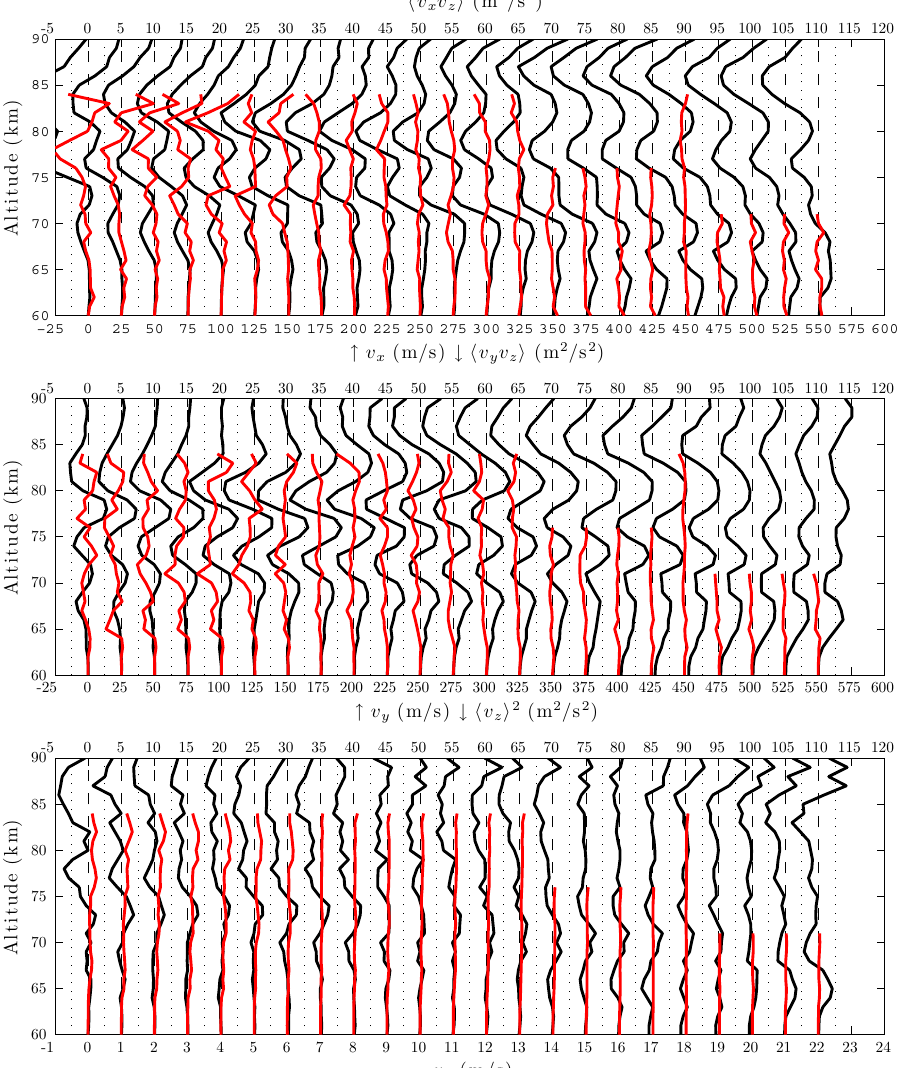
Fig. 8. Winds and momentum fluxes from 13:00–24:00UT on 23 April 2008. Top: Zonal wind (black, v x ) and vertical flux of horizontal momentum (red, h v e v z i , top axis). Winds are two-hour averages plotted every hour, separated by 25ms − 1 . Momentum fluxes are computed over the two-hour period and are separated by 5m 2 s − 2 . Middle: Same for the meridional winds and momentum flux. Bottom: Vertical ve- locity (black, v z ) and vertical velocity variance (red, h v z i 2 , top axis). Vertical winds are separated by 1ms − 1 and vertical velocity variances by 5m 2 s − 2